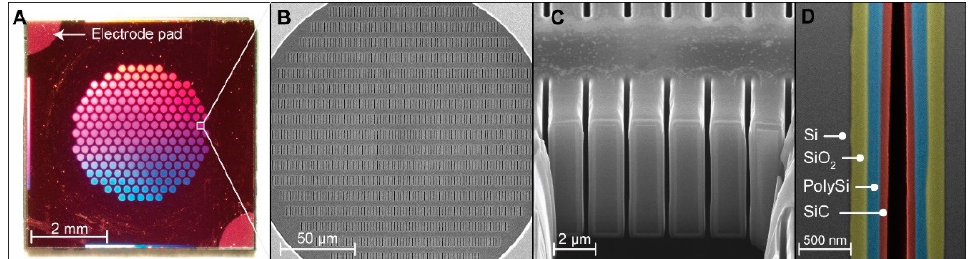
Figure 1. Image of the silicon nanofluidic membrane. ( A ). Final diced membrane with a size of 6 mm × 6 mm × 0.4 mm. In the photograph, the exposed contact pads of the polysilicon electrode used for connection to the external source for the polarization potential are indicated. ( B ) SEM image of the highly densely packed parallel nanochannel design. ( C ) FIB-SEM vertical cross-section showing the membrane nanochannels. ( D ) FIB-SEM vertical cross-section image of the wall of a nanochannel. The layers obtained at different stages of the photolithographic processes were color-enhanced to highlight the native original p-Si of the device layer of the wafer (in gray), thermally grown silicon dioxide (SiO 2 , ~175 nm, in green), poly-Si deposited by LPCVD (~121 nm, in blue), and a-SiC deposited by PECVD (64 nm, in red).